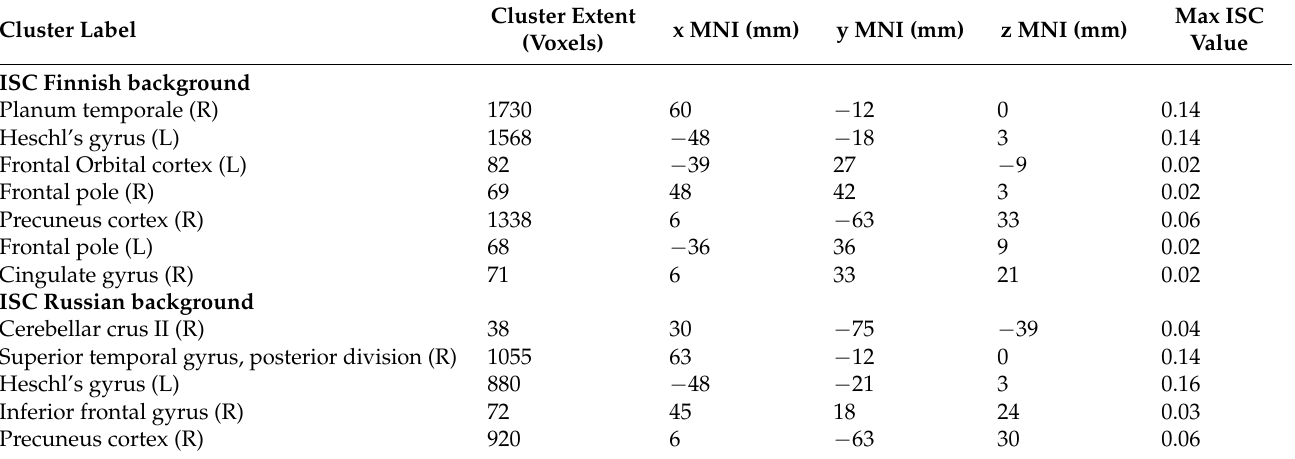
Table 2. ISC values across Finnish- and Russian-family-background participants. Labels, sizes, peak coordinates, and maximum intersubject correlation (ISC) values of clusters obtained in the ISC analysis for the participants with Finnish and for the participants with Russian family backgrounds. The loci of ISC were labeled according to the Harvard–Oxford Cortical Structural Atlas implemented in the FMRIB Software Library (FSL, https://fsl.fmrib.ox.ac.uk/fsl/fslwiki, accessed on 12 May 2022). The coordinates are in Montreal Neurological Institute and Hospital (MNI) coordinate space. L = left, R = right.